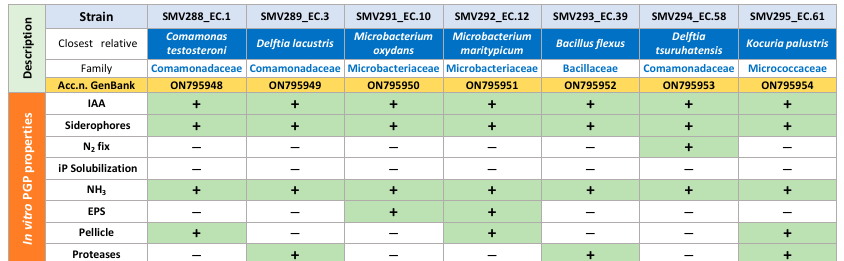
Figure 1. List of arsenic-tolerant bacterial endophytes isolated from the roots of hemp seedlings grown on an As-contaminated soil and the results of the tests performed on them. Genbank accession numbers and in vitro PGP properties are shown.